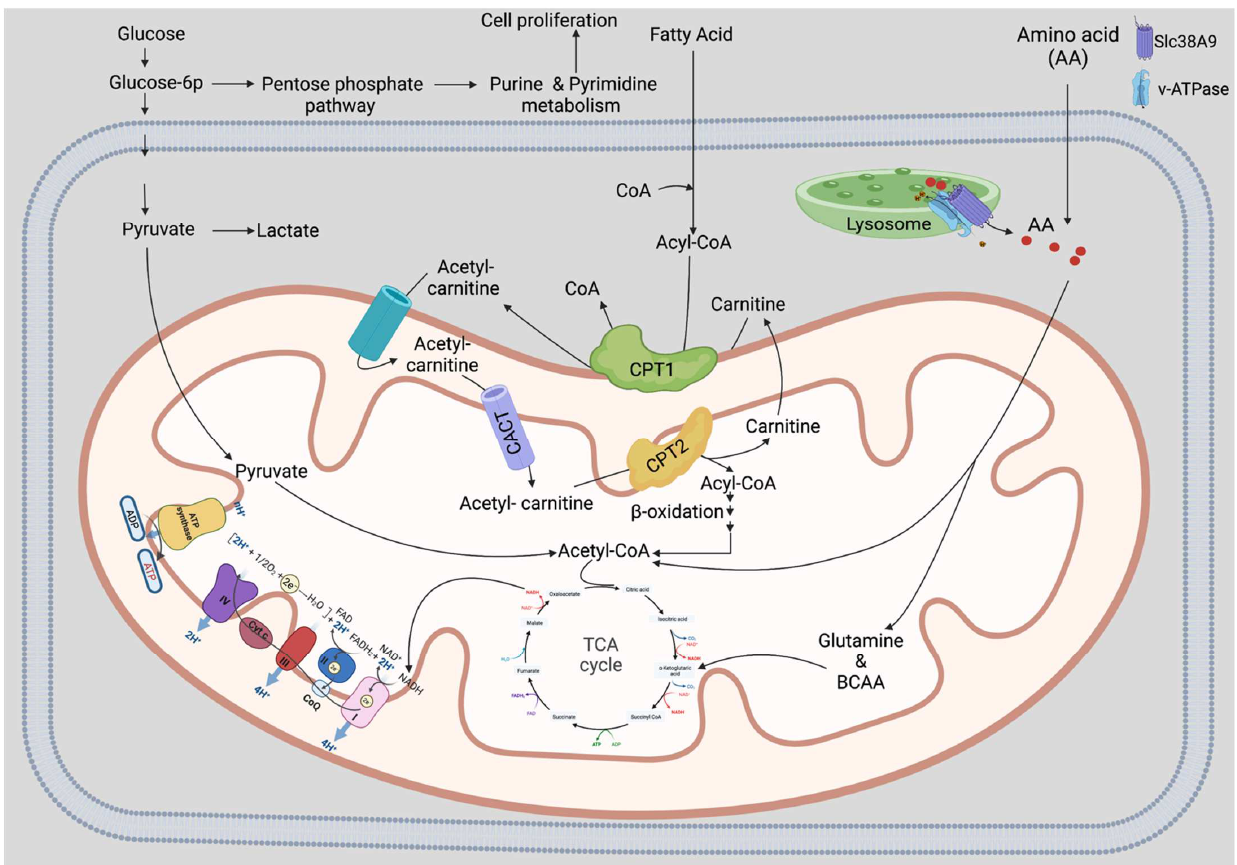
Figure 3. Role of mitochondria and lysosomes in HSC maintenance. The metabolic mechanisms that aid in HSC self-renewal, differentiation, and glycolysis fuel the metabolic pathway for active HSCs. In the glycolysis pathway, glucose is degraded into glucose-6P, which undergoes a series of reactions and is converted to pyruvate. Pyruvate generates energy for active HSCs in the TCA cycle. Simultaneously, the production of nucleotides like purine and pyrimidine also requires glucose-6P and utilizes in the pentose phosphate pathway, which is critical for cell proliferation and activating HSCs adapted with permission [6]. Alternatively, HSCs are activated by unknown mechanisms byproducts such as amino acids (AAs), or other nutrients release from the lysosomes may be shuttled to the mitochondria from the cytosol, where they are converted to acetyl-CoA and enter the TCA cycle to produce ATP. HSCs are activated when TCA cycle is activated by alpha-ketoglutarate ( α -KG), the end product of glutamine in the mitochondria. Instead of using glucose for energy generation, the catabolism of branched-chain amino acids (BCAAs) also feeds the TCA cycle through α -KG to produce ATP. FAO, a crucial ATP-producing catabolic pathway, feeds the TCA cycle rather than glycolysis. Long-chain fatty acids are converted into short chain fatty acyl-CoA in the cytosol and subsequently transported by carnitine palmitoyltransferase 1 (CPT1), carnitine-acylcarnitine translocase (CACT), and carnitine palmitoyltransferase (CPT2) into the mitochondria through carnitine pathway. Here, β -oxidation yields acetyl-CoA to drive the TCA cycle adapted with permission [6]. FAO is vital to HSC maintenance. Created with BioRender.com 21 September